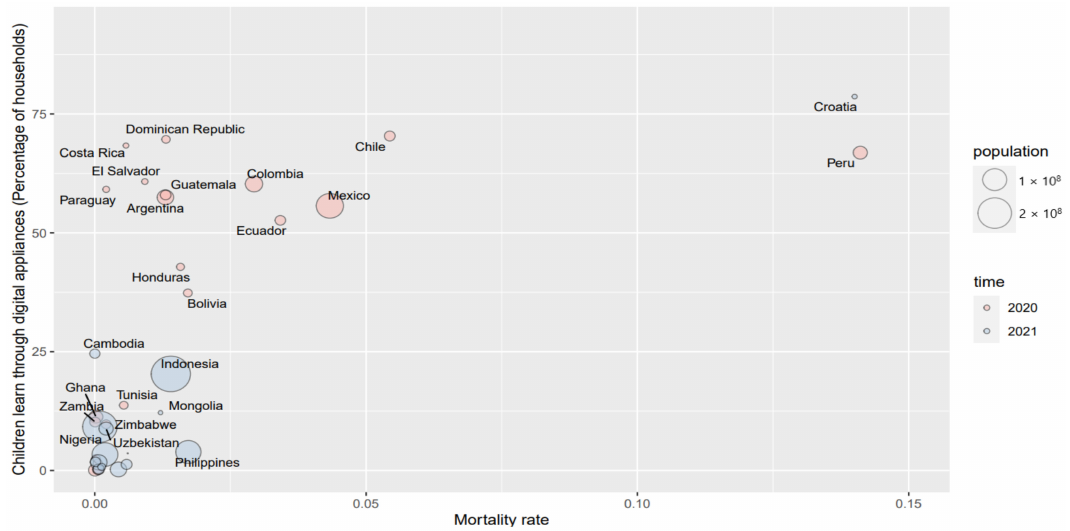
Figure 6. The pattern of the mortality rate and digital appliances in children’s education since school